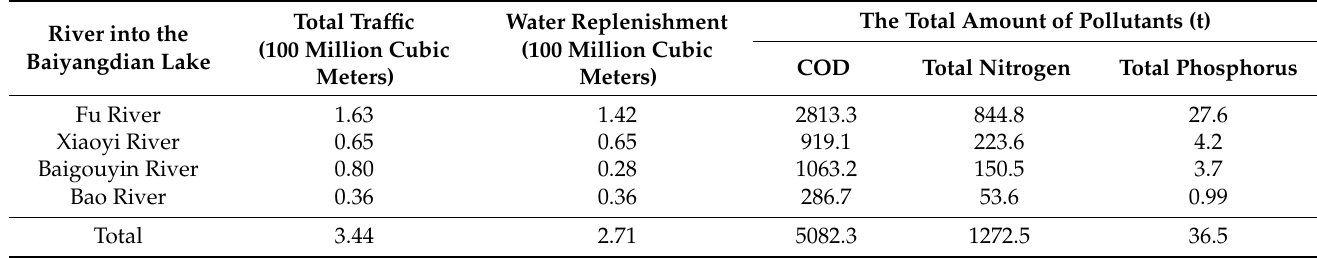
Table 4. The amount of water and pollutants entering Baiyangdian lake in 2020.